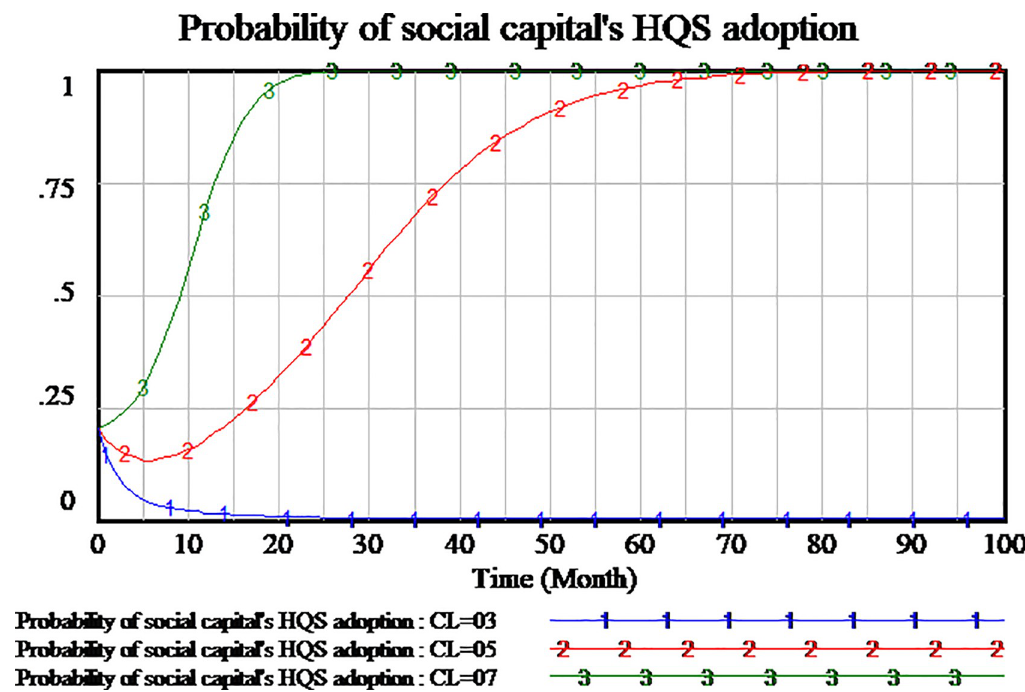
Fig 18. Impact of different cost of low-quality service on social capital.